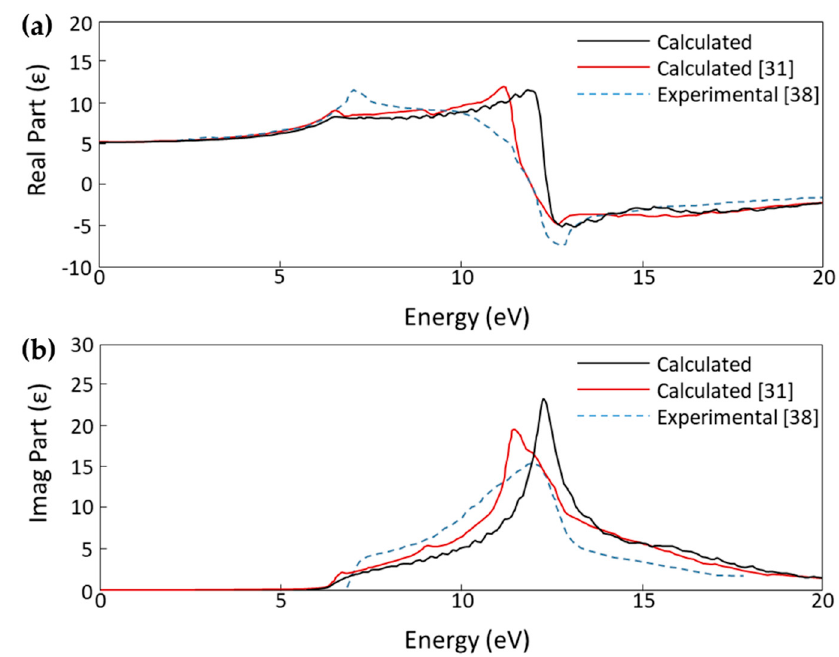
Figure 4. ( a ) Real part and ( b ) imaginary part of the calculated dielectric constant ( ε ) plots for bulk diamond comparing our calculated results with calculated results by Xiang et al. and experimental results by Philipp and Taft [31,38].